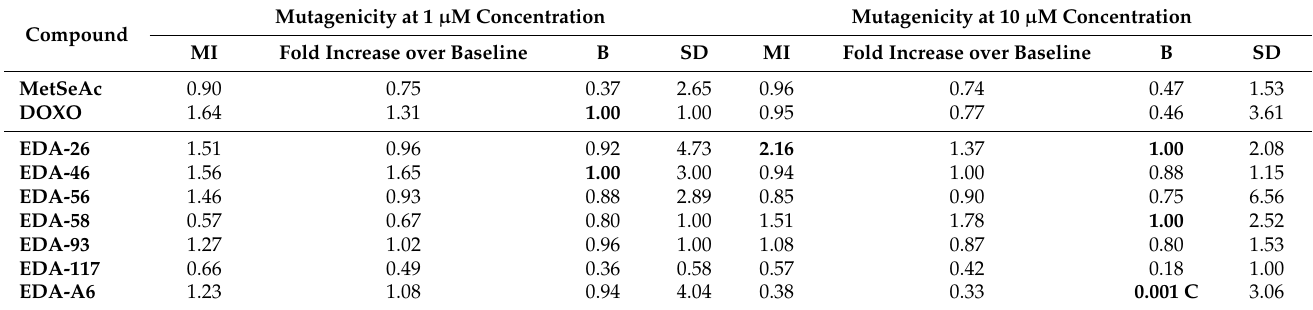
Table 5. Mutagenic index (MI) and other values for methylseleninic acid (reference Se